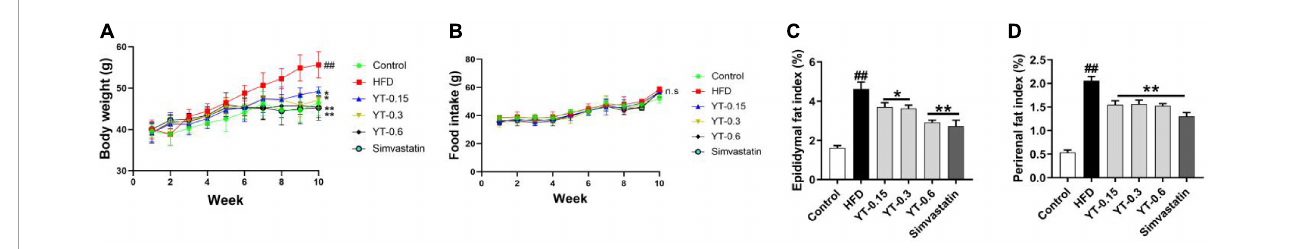
FIGURE1 Effect of YT extract on body weight and fat index. (A) Body weight, (B) food intake, (C) epididymal fat index, (D) perirenal fat index. Data are presented as mean ± SEM ( n = 6). # p < 0.05 and ## p < 0.01 vs. the control group; * p < 0.05 and ** p < 0.01 vs. the HFD group. ns indicates no significant difference between the control and HFD groups. Fat index = (fat weight/body weight) × 100%.